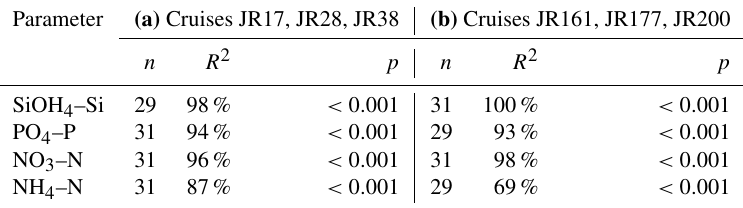
Table 3. Relationship between mean surface (0 to 7m) nutrient data with those averaged over 0 to 50m using linear regressions. All available data from six cruises were examined during two studies: (a) to the north of South Georgia with 50% of stations on-shelf (Whitehouse et al., 2009); (b) repeated transects across the Scotia Sea sampling deep oceanic waters (Whitehouse et al., 2012).